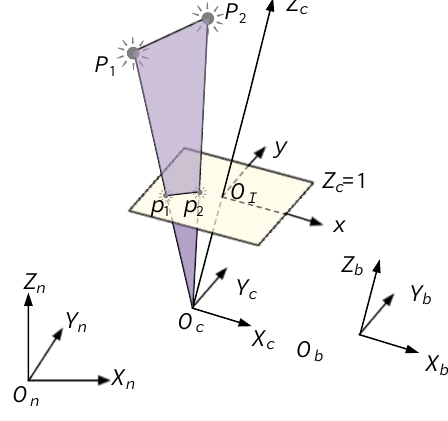
Figure 1. The frames of reference and camera